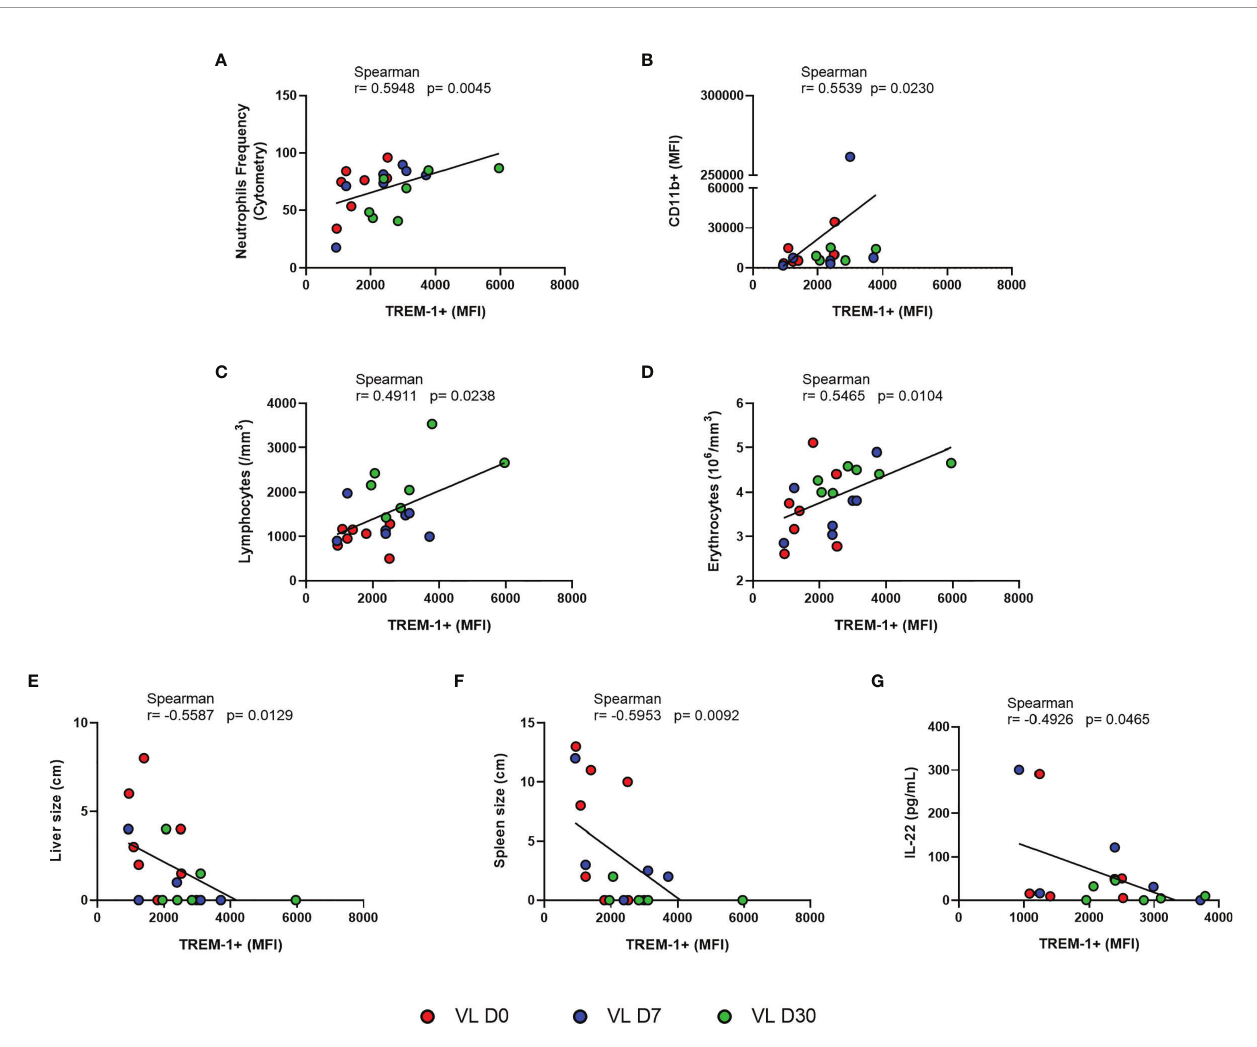
FIGURE 2 | Correlation between MFI of TREM-1 and (A) neutrophil frequency, (B) MFI CD11b, and (C – G) laboratory parameters and clinical and IL-22 serum levels from patients with VL at different times of leishmanicidal treatment. Spearman correlation test. Patients with VL before treatment are represent in red; and after treatment initiation with 7 days in blue, and 30 days in